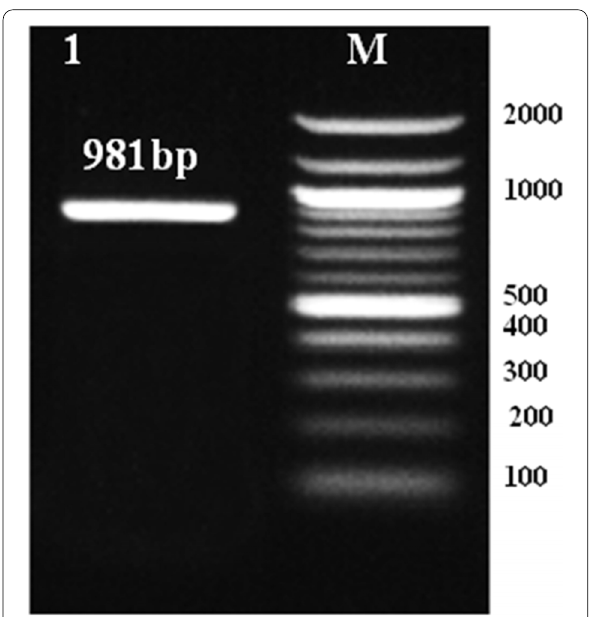
Fig. 16 Agarose gel electrophoresis for PCR product of xyn C gene (in lane 1). Lane M, 100 bp DNA ladder (Invitrogen, California,